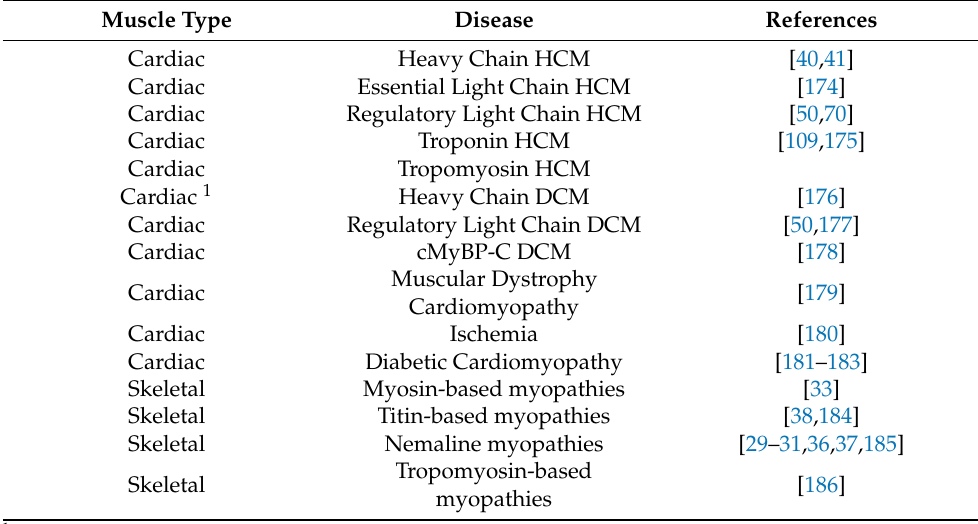
Table 1. Studies of Myopathies Using X-ray